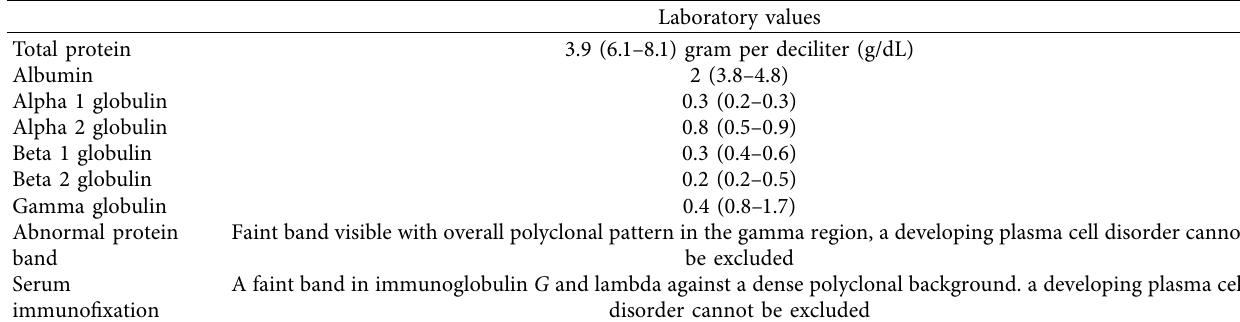
Table 2: Serum protein electrophoresis with immunofixation.